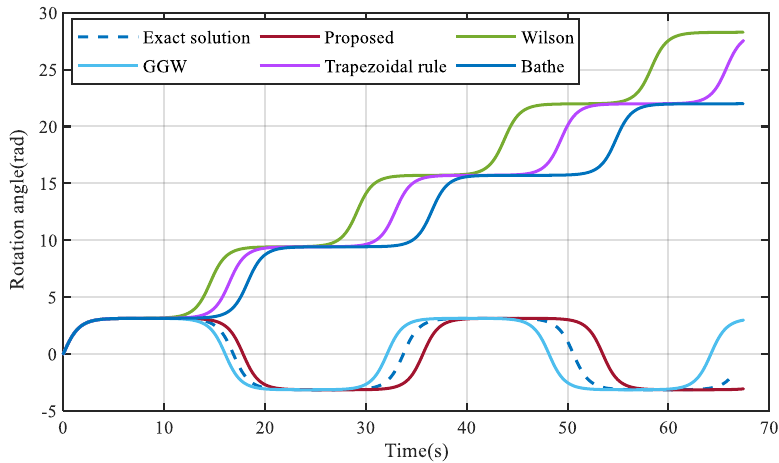
Figure 9. Numerical solutions with the Wilson method, Bathe method, GGW method, trapezoidal rule and the proposed method when Δ t / T = 1/10000.